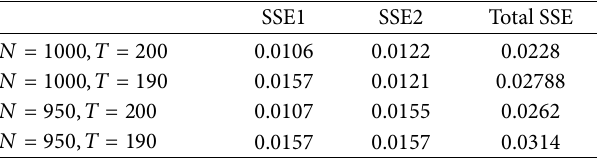
Table 2: SSE of the full sample and three